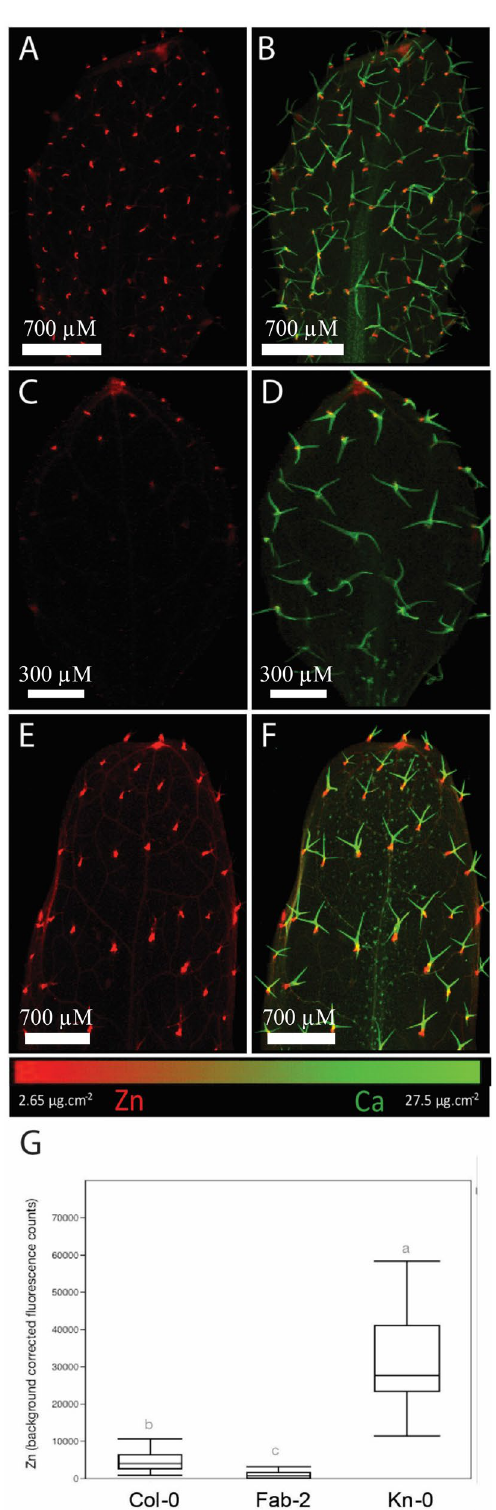
Figure 4. Total Zn per trichome of A. thaliana natural accessions with contrasting bulk leaf Zn concentrations. Total Zn abundance in trichomes was quantified using Region of Interest (ROI) analysis of leaves. All trichomes in each leaf presented in the maps were included in the analyses (n = 25–61). Significant differences by one-way ANOVA and Tukey HSD are shown. Panels show Col-0 leaf Zn ( A ) and Zn and Ca ( B ); Fab-2 leaf Zn ( C ) and Zn and Ca ( D ); Kn-0 leaf Zn ( E ) and Zn and Ca ( F ) localization. All plants were cultivated under 50 µM Zn, and the 7th true leaf was